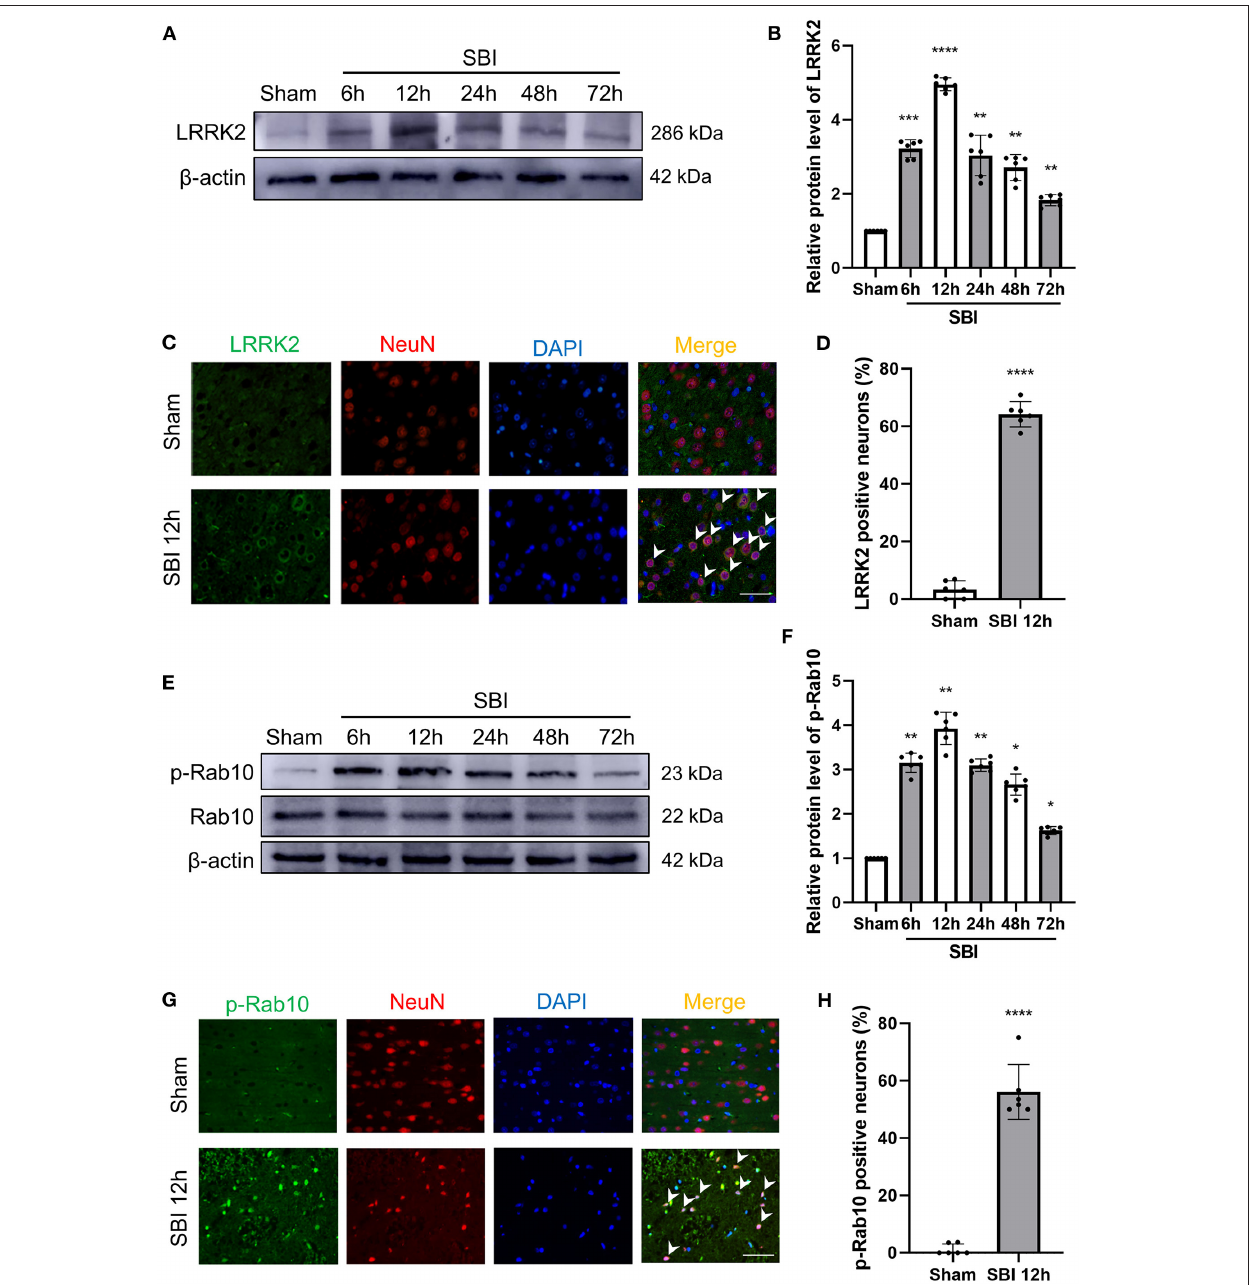
FIGURE 2 | Post-SBI protein expression level and immunofluorescent staining of LRRK2 and p-Rab10 in peri-injury cortex. (A,B) LRRK2 protein level in brain after SBI. (C,D) Double immunofluorescence analysis of LRRK2 (green) in neurons (red) near the damaged area after SBI. (E,F) Rab10/p-Rab10 protein level in brain after SBI. (G,H) Double immunofluorescence analysis of p-Rab10 (green) in neurons (red) near the damaged area after SBI. Nuclei were labeled with DAPI (blue). Bar = 50 µ m. Data = mean ± SD, N = 6. * P < 0.05, ** P < 0.01, *** P < 0.005, **** P < 0.001 vs. Sham; ns P > 0.05 vs. Sham.